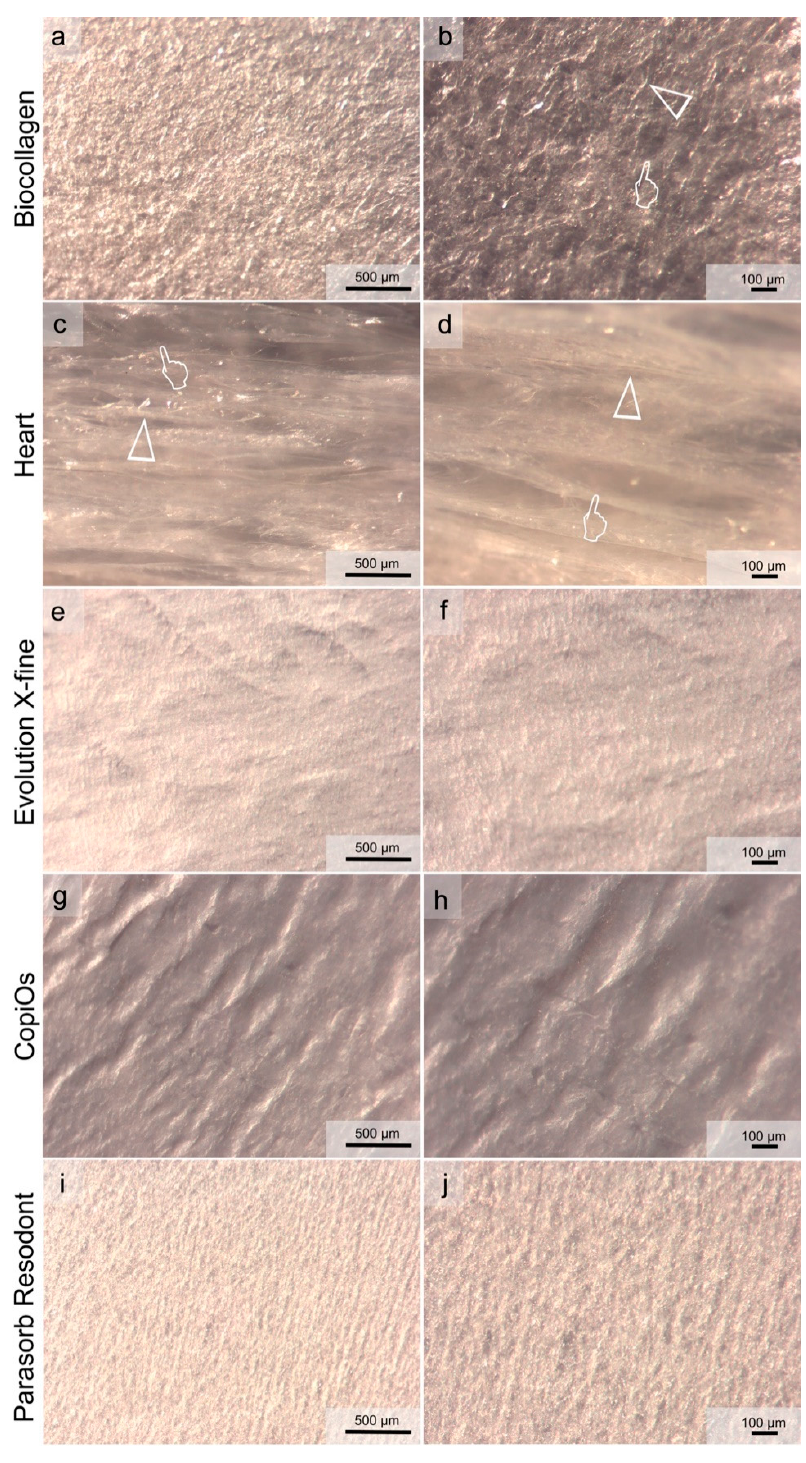
Figure 3. Light micrographs taken of the smooth surface of the membranes before immersion. ( a ) Biocollagen surface at 60× magnification. ( b ) Biocollagen at 120× magnification. ( c ) Heart surface at 60× magnification. ( d ) Heart at 120× magnification. ( e ) Evolution X-fine surface at 60× magnification. ( f ) Evolution X-fine surface at 120× magnification. ( g ) CopiOs surface at 60× magnification. ( h ) CopiOs surface at 120× magnification. ( i ) Parasorb Resodont surface at 60× magnification. ( j ) Parasorb Resodont surface at 120× magnification. In ( a , c , e , g , i ), the scale bar is 500 μ m, and it is 100 μ m in ( b , d , f , h , j ). Pointers indicate pores of different size across the membrane’s surface. Arrow heads indicate collagen fibers.